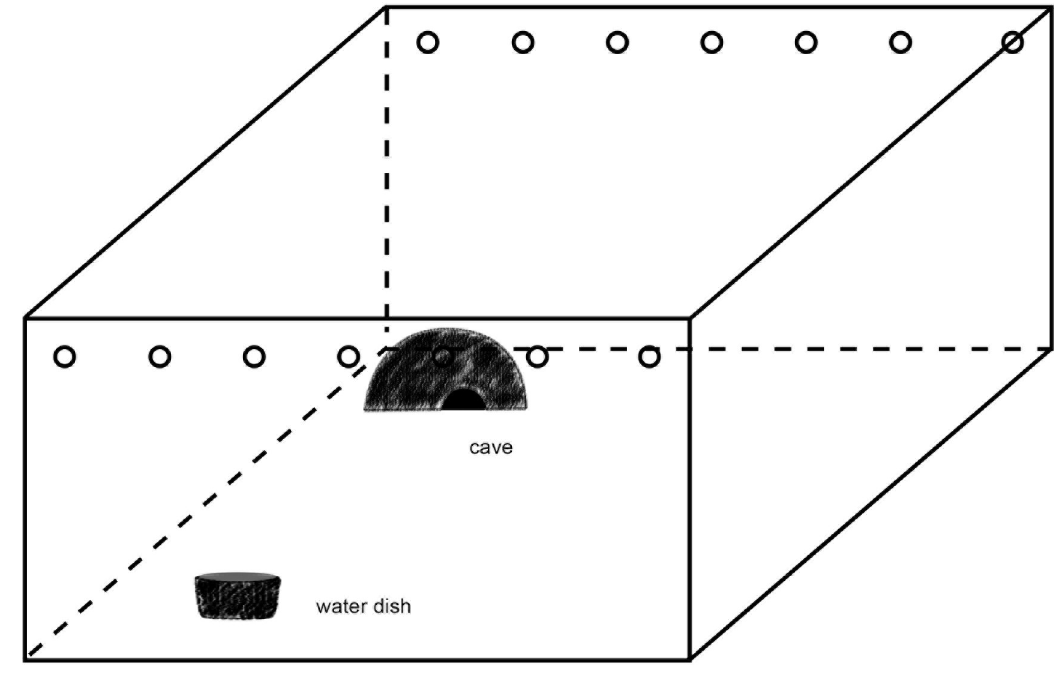
Fig 1. Schematic view of a rack